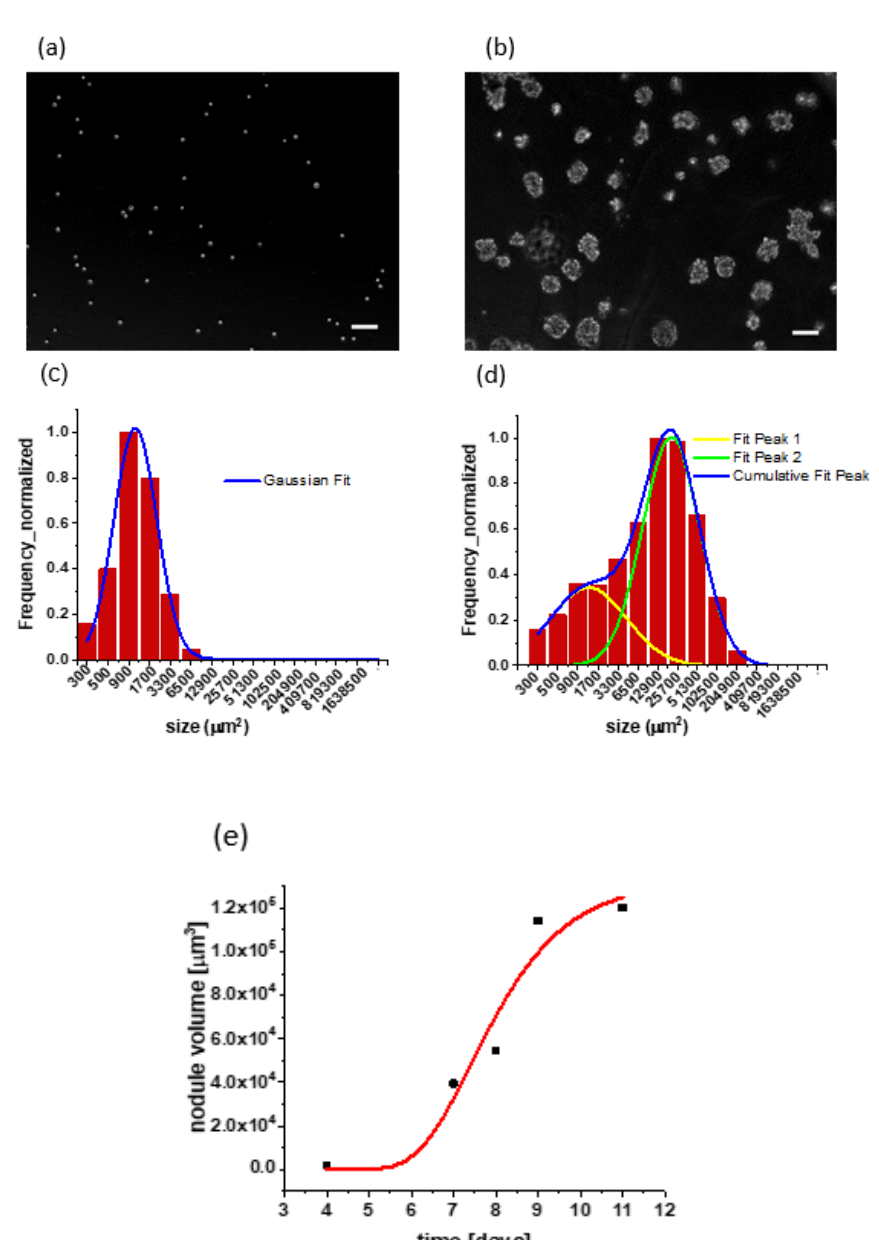
Figure 2. Longitudinal monitoring of 3D culture growth: ( a ) darkfield images show adherent single cells clearly visible at day zero. Scale bar is equal to 100 µ m; ( b ) heterogeneous multicellular tumor nodules are formed at day seven. Scale bar is equal to 100 µ m; ( c ) the first visible signs of heterogeneity appear on day four. Although one Gaussian fit is applied, the first two bars represent the beginning of another peak formation. The size of cancer nodules given in square micrometers corresponds to the area of a 2D projection (from 2D image data) of a 3D tumor nodule; ( d ) bimodal size distribution of 3D nodules at day seven in which the first peak corresponds to a smaller population with a mean size of about 1300 µ m 2 , and the second peak includes a larger population with a mean size of 19,300 µ m 2 ; ( e ) growth kinetics plot (Gompertzian fit): average size of A549 3D nodule over time. The 3D nodule grew from day zero to day nine, when it reached a plateau due to stagnation in further growth.